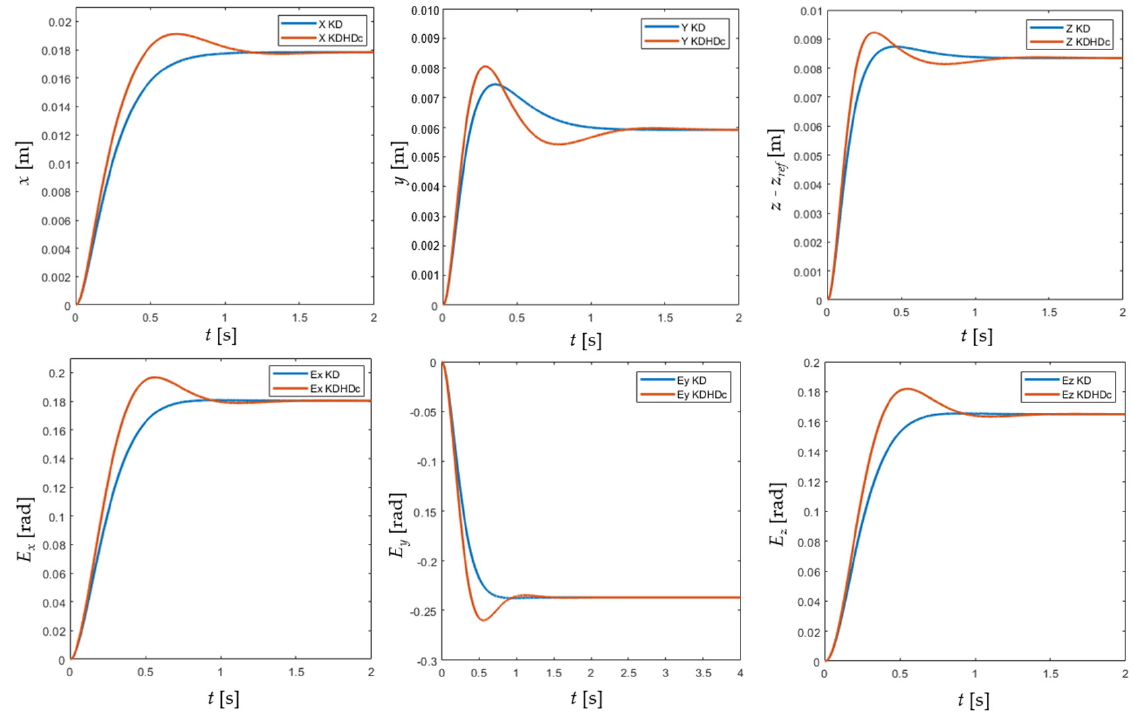
Figure 6. Case study C, KD–KDHDc comparison, external coordinates.